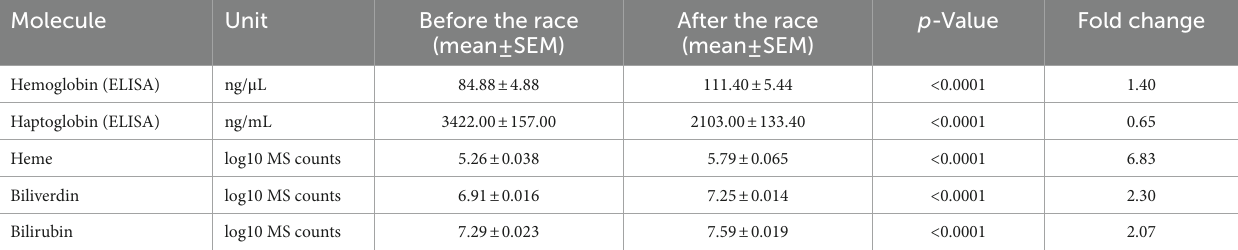
TABLE 1 Mean levels and standard error of the mean for hemolysis molecules studied before the race (BR), after the race (AR) and their fold change. Molecule Unit Before the race